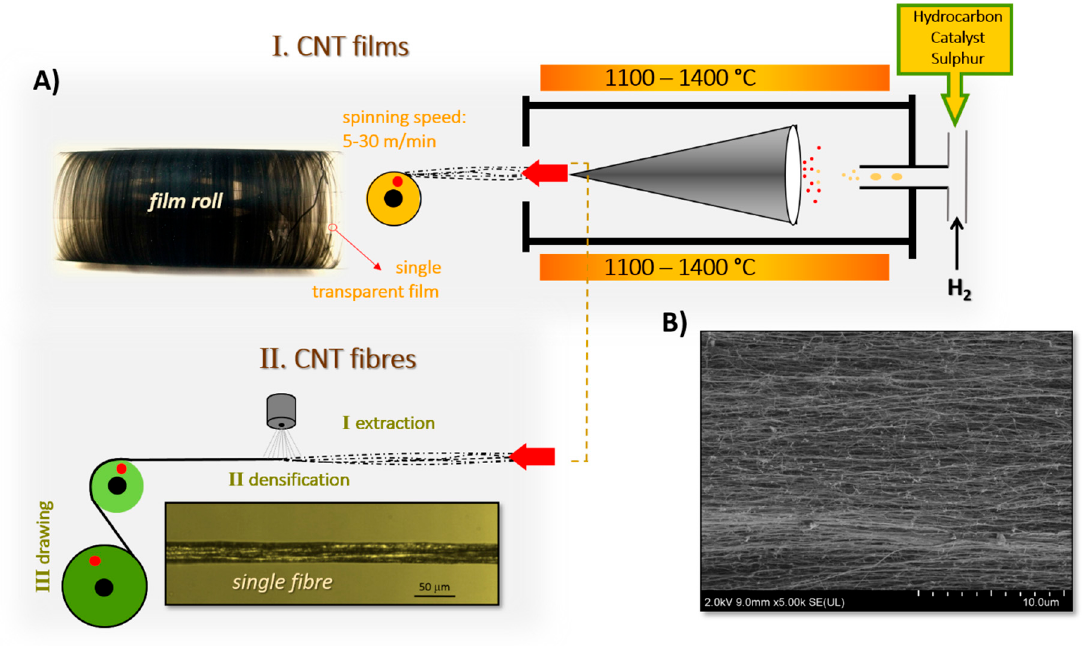
Figure 1. ( A ) Direct spinning of (I) carbon nanotube (CNT) films and (II) CNT fibers using a floating catalyst (CVD) process. ( B ) Scanning electron microscope image presenting alignment of CNT bundles in a CVD-spun CNT fiber.